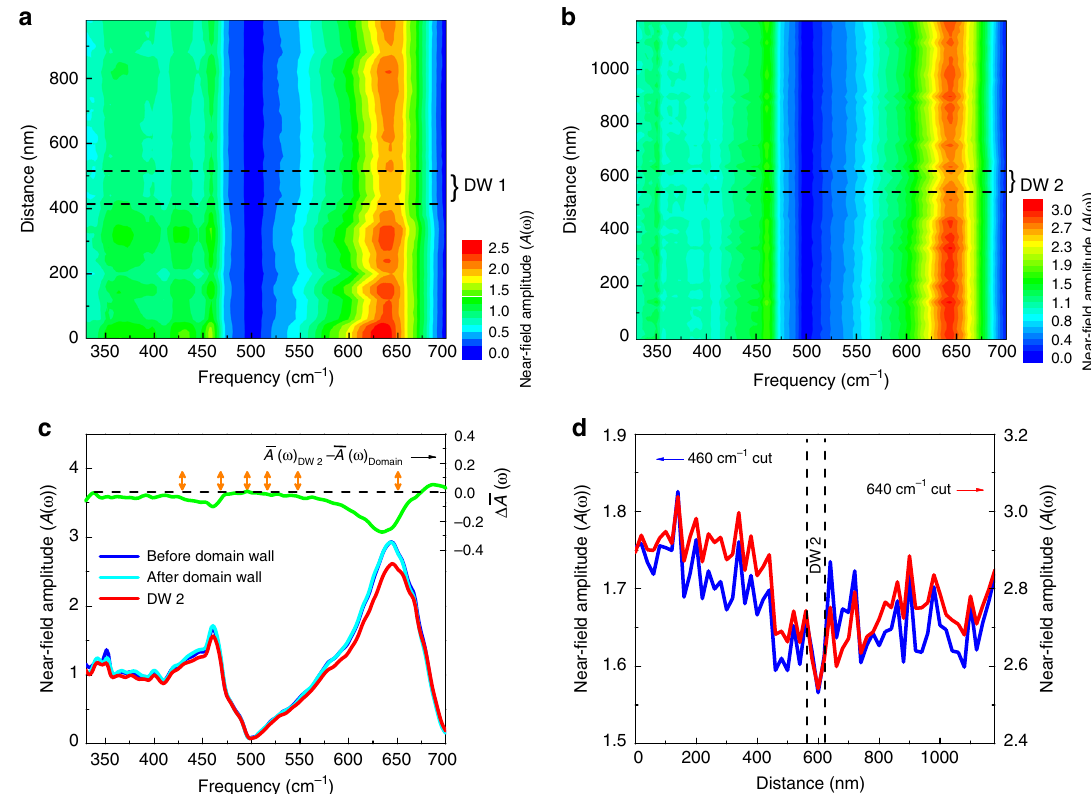
Fig. 3 Near- fi eld infrared spectroscopy of Ca 3 Ti 2 O 7 . a , b Contour plots of the near- fi eld amplitude normalized to a gold reference across two different domain walls as indicated in Fig. 2a, b. We label these walls as DW 1 and DW 2. The step size is 20 nm, and the tip resolution is 20 ´ 20 nm 2 . The black dashed lines indicate the domain wall locations, and the brackets denote effective wall widths. c Fixed distance cuts of the contour spectra in b show A ( ω ) at the ferroelastic domain wall compared with two different point scans away from the wall. Average changes in the near- fi eld amplitude, calculated as Δ A ( ω ) = A ( ω ) A ð ω Þ , reveal the difference and, at the same time, reduce the noise. Here the bars denote an average response. This analysis DW 2 (cid:3) Domain demonstrates that wall phonons have reduced amplitude and a slight blue shift. The six A 1 modes within the experimental energy window are indicated by double-sided orange arrows. d Fixed frequency cuts of the contour data in b showing how intensity at 460 and 640 cm (cid:3) 1 varies across DW 2. According to the calculation of Δ A ( ω ) in c , these frequencies are most sensitive to the presence of the domain wall. They are also very near the calculated A 1 symmetry vibrational modes (shown as orange arrows in c